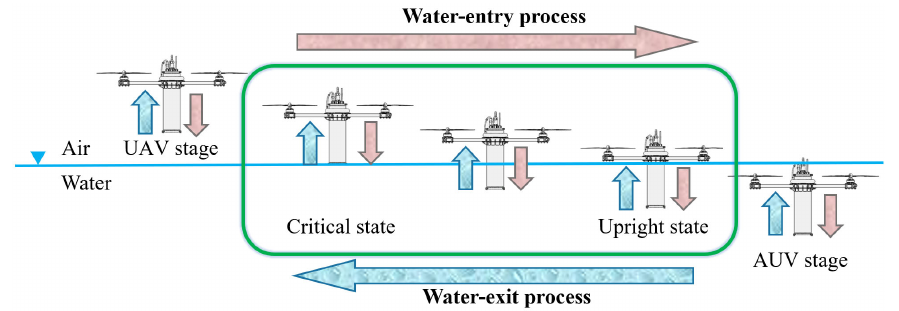
Figure 3. Diagram of the trans–media process.